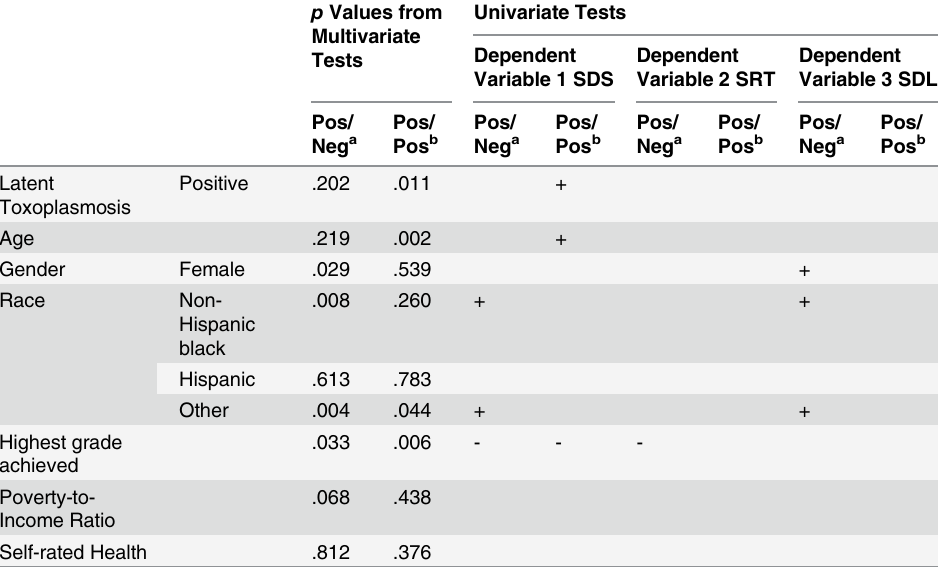
Table 3. Direction of signi fi cant interactions of H. pylori and CagA with model variables, and p values of multivariate tests. p Values